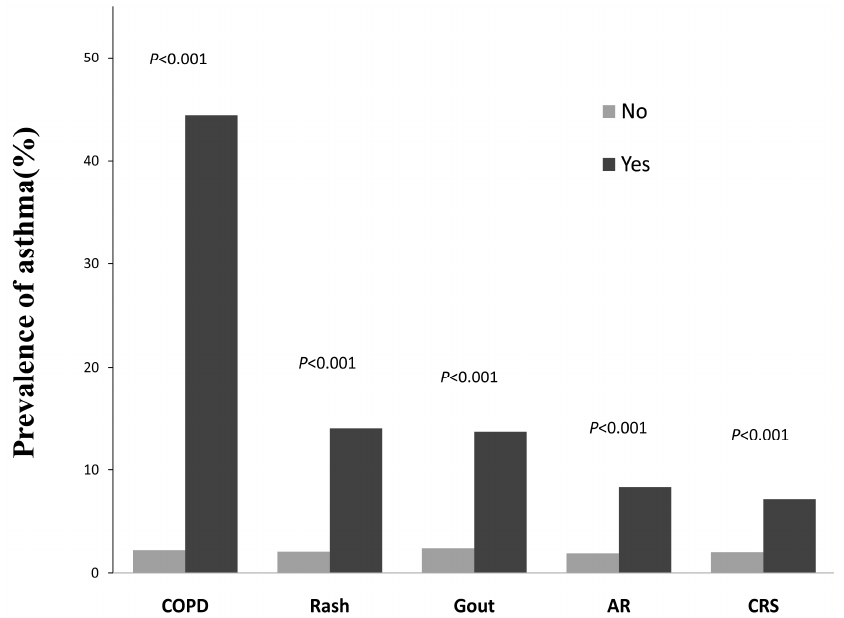
Figure 1. The prevalence of self-reported lifetime asthma in subjects with and without specific medical disorders, including chronic obstructive pulmonary disease (COPD), rash, gout, allergic rhinitis (AR), and chronic sinusitis (CRS). Table 3. The effects of environmental and occupational factors on lifetime asthma.